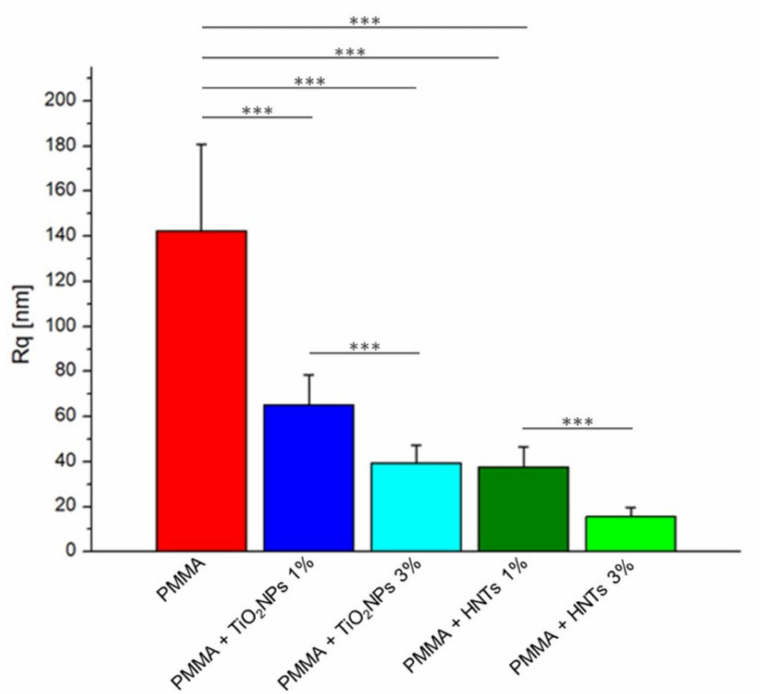
Figure 5. Roughness values (Rq) expressed as mean value and standard deviation on PMMA-based substrates. Obtained Rq value were considered statistically significant respect to control (PMMA) for p -value < 0.005